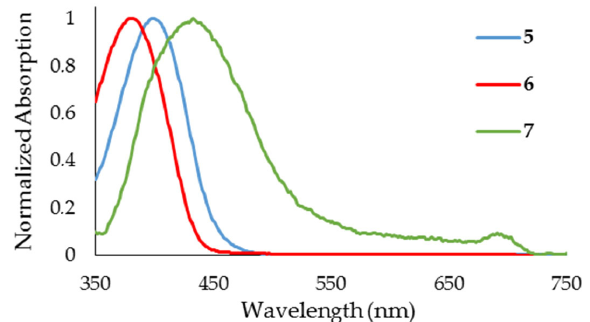
Figure 2. Absorption spectra of push-pull heterocyclic dyes 5 and 6 in ethanol and dye 7 in DMSO, at room temperature.